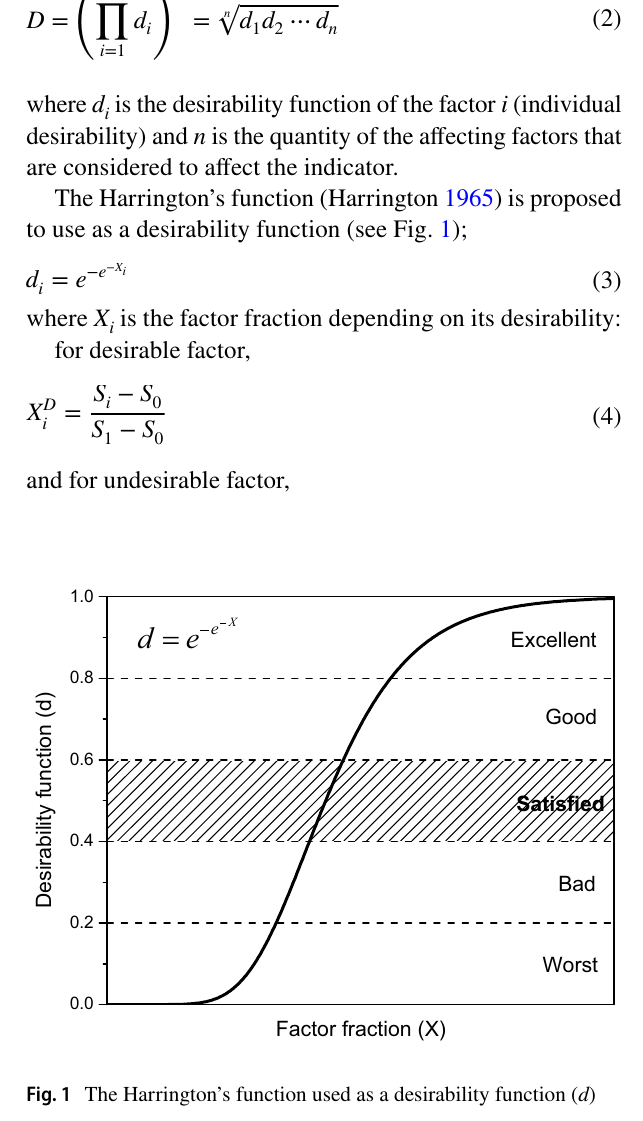
Fig. 1 The Harrington’s function used as a desirability function ( d